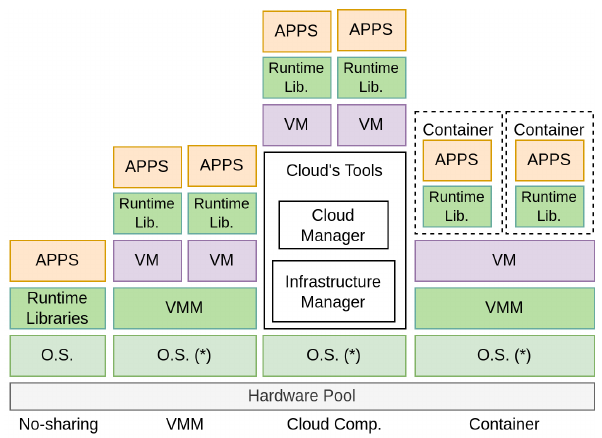
Figure 3. Virtualization technology used in our proposed